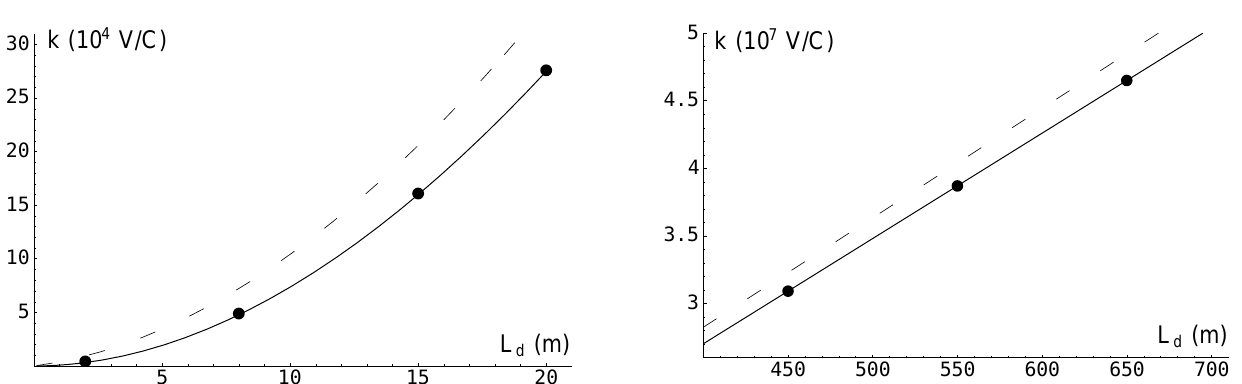
FIG. 2. Loss factor k as a function of the length of the perforated beam screen L d (for a device length L d much shorter than the attenuation length L a (cid:6) 80 m). The solid line refers to Eq. (17) and the dots give the exact numerical values from Eq. (8). The dashed line is obtained neglecting backward wave. We use the following parameters: b (cid:1) 19 mm, d (cid:1) 24.5 mm, r b (cid:1) r d (cid:1) 7.1 3 10 2 7 V (cid:1) m, D (cid:1) 16 mm, s (cid:1) 75 mm, rounded end slots 8 mm 3 1.5 mm.